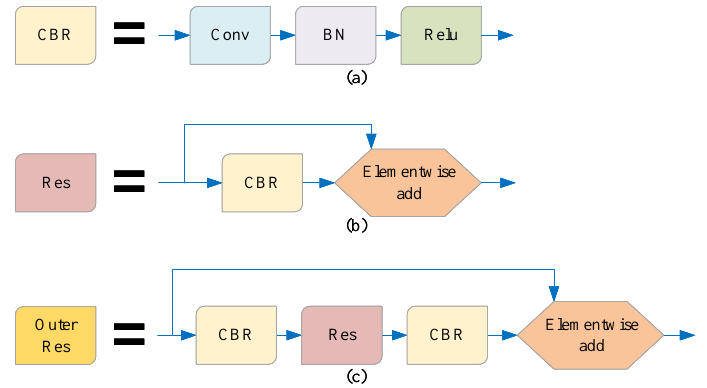
Figure 2. The names of some basic network combinations are simplified in this paper. ( a ) The combination of the convolution layer, BN layer, and ReLU activation function is referred to as the CBR unit; ( b ) the combination of the CBR unit and residual structure is referred to as the RES unit; ( c ) the combination of CBR-Res-CBR and residual structure is referred to as the Outer Res